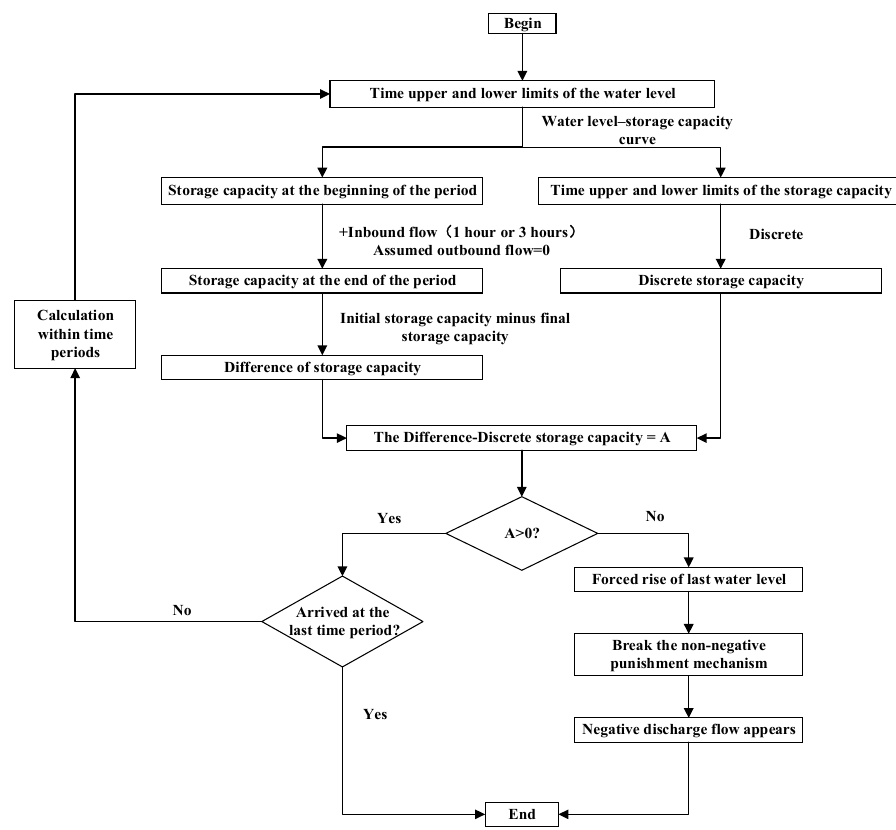
Figure 4. Flow chart of the negative value of discharge flow.